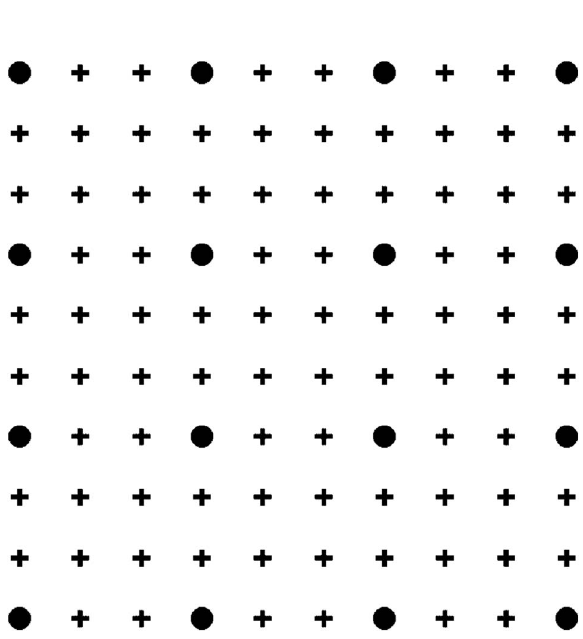
Fig. 9. The circles are where the LETKF assimilation is performed. The higher resolution grid (crosses) is then found by interpolation of the weight vectors. Image from Yang et al.